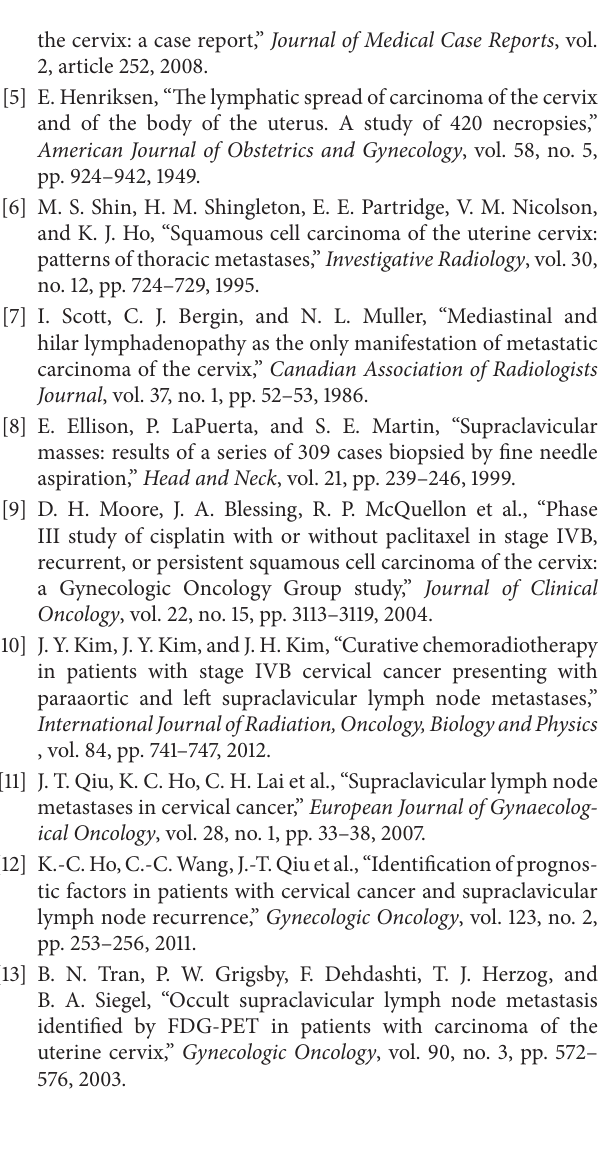
FDG-PET: Flouro-deoxyglucose positron emission